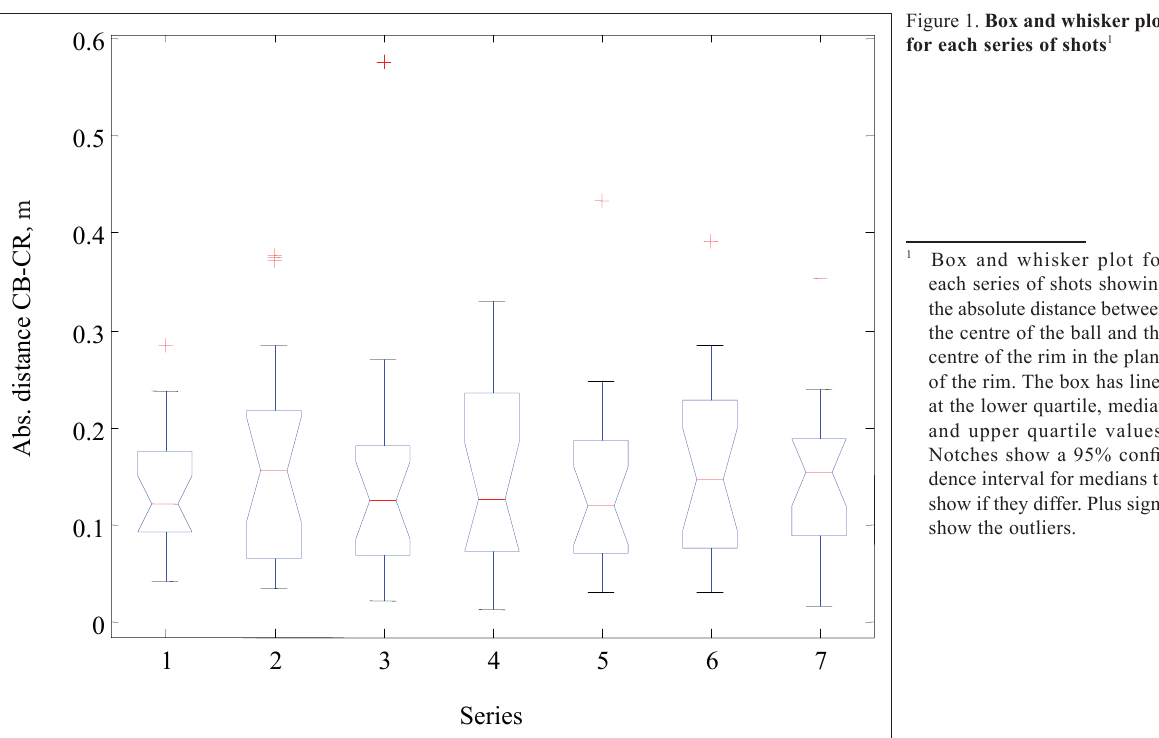
1 Box and whisker plot for each series of shots showing the absolute distance between the centre of the ball and the centre of the rim in the plane of the rim. The box has lines at the lower quartile, median and upper quartile values. Notches show a 95% con fi - dence interval for medians to show if they differ. Plus signs show the